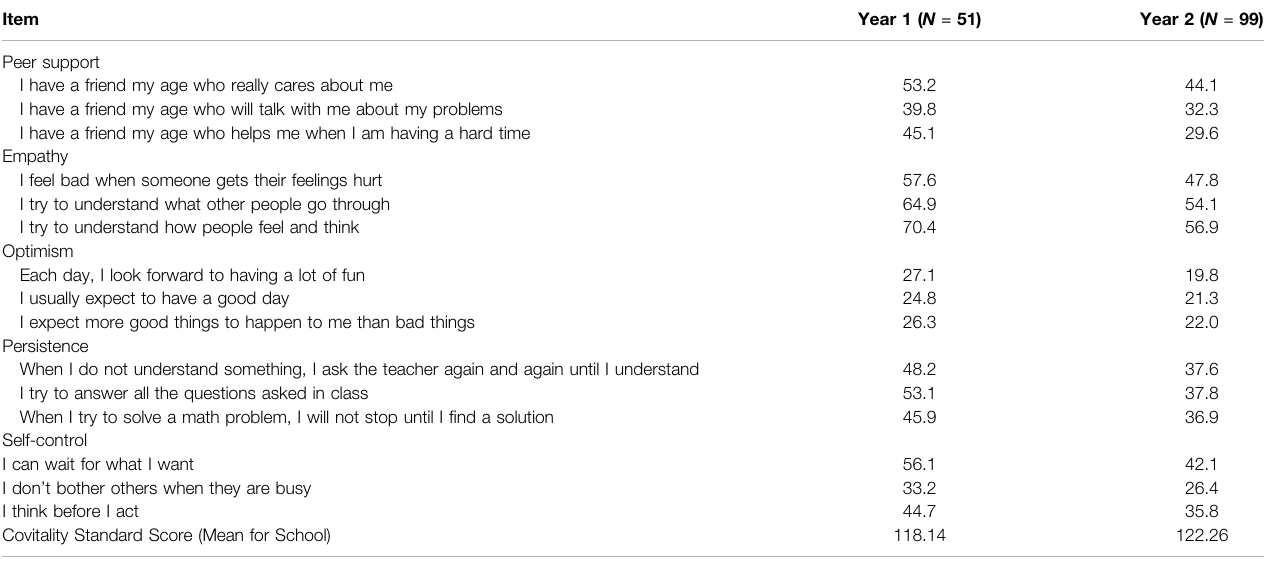
TABLE 3 | Percentage of students who endorsed positive responses to SEHS